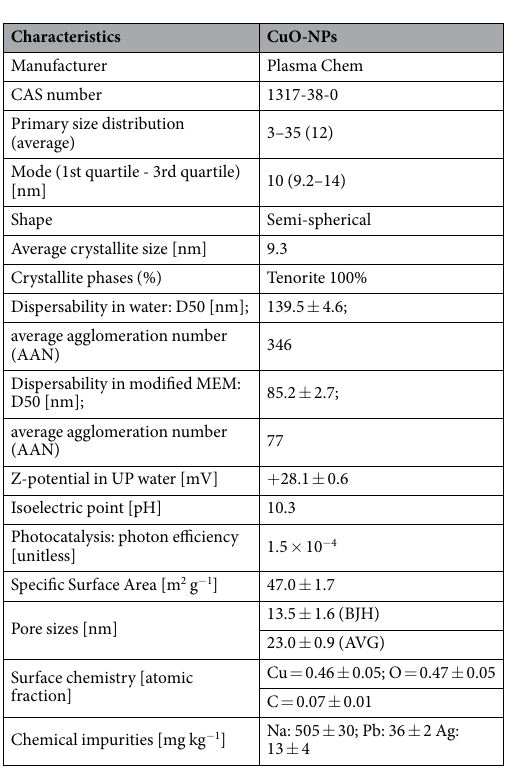
Table 3. Characteristics of the tested CuO-NPs (Source: FP7-SUN